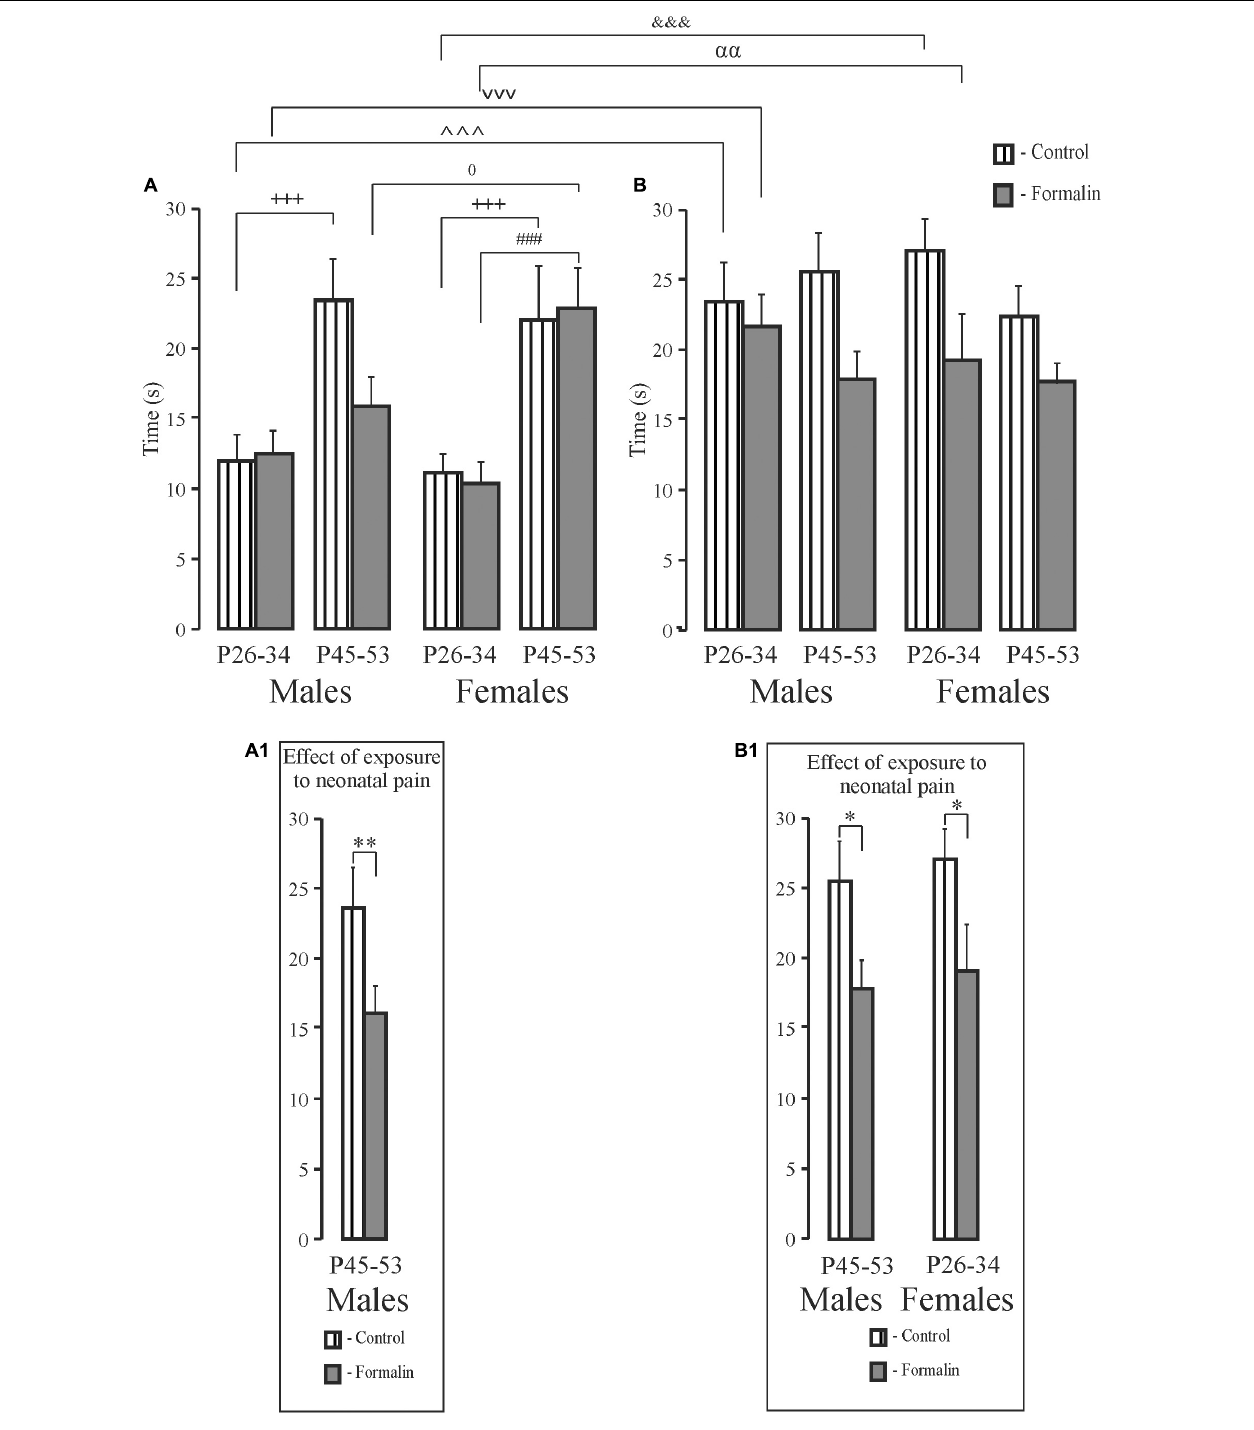
FIGURE 5 | Mean ( ± SEM) time in target quadrant (A,B) for short-term (A) and long-term (B) spatial memory in the Formalin or Control male and female rats for the early (P26-34) and late (P45-53) age groups. Differences in time in target quadrant between short-term and long-term memory were found in Control and Formalin males and females of early age groups. In all cases, the time in target quadrant was shorter in the short-term memory (A,B) . +++ p < 0.001, age differences in Control rats; ### p < 0.001, age differences in Formalin rats. Differences between short- and long-term memory: in time in target quadrant, ∧∧∧ p < 0.001, &&& p < 0.001 in Control P26-34 males and females, vvv p < 0.001, αα p < 0.01, in Formalin P26-34 males and females; 0 p < 0.05, sex differences in P45-53 Formalin rats. The number of the rats in the groups corresponds to the number of rats in Figures 1 , 2 . The graphs below illustrate significant results of statistical analysis. ∗ p < 0.05, ∗∗ p < 0.01 significant effect of exposure. Graphs (A1) and (B1) illustrate the significant outcomes of the statistical analyses.